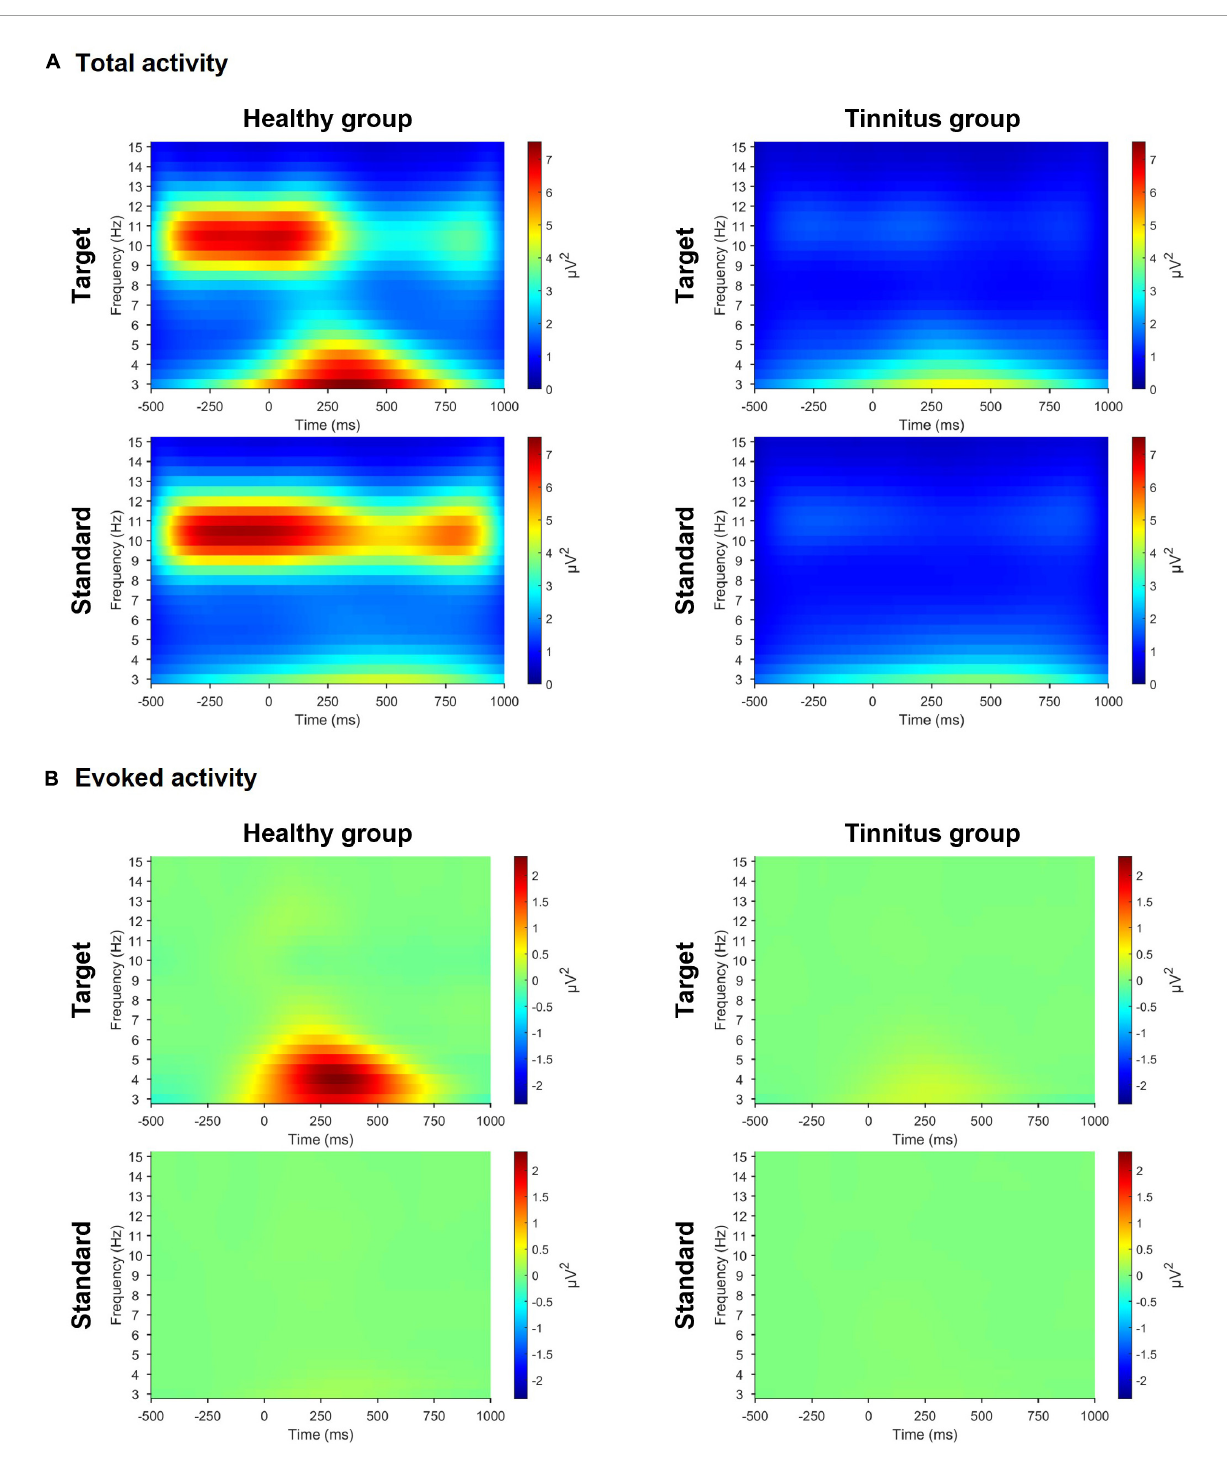
FIGURE3 Time-frequency representations in the active oddball task. (A) Time-frequency representations of grand-averaged total activity across three parietal electrodes (Pz, P3, and P4) during the active oddball task. (B) Time-frequency representations of grand-averaged evoked activity across the same three parietal electrodes during the active oddball task. Note the pronounced pre-stimulus total alpha (8–13 Hz) and evoked theta (4–8 Hz) activities in the healthy group compared with the tinnitus group.